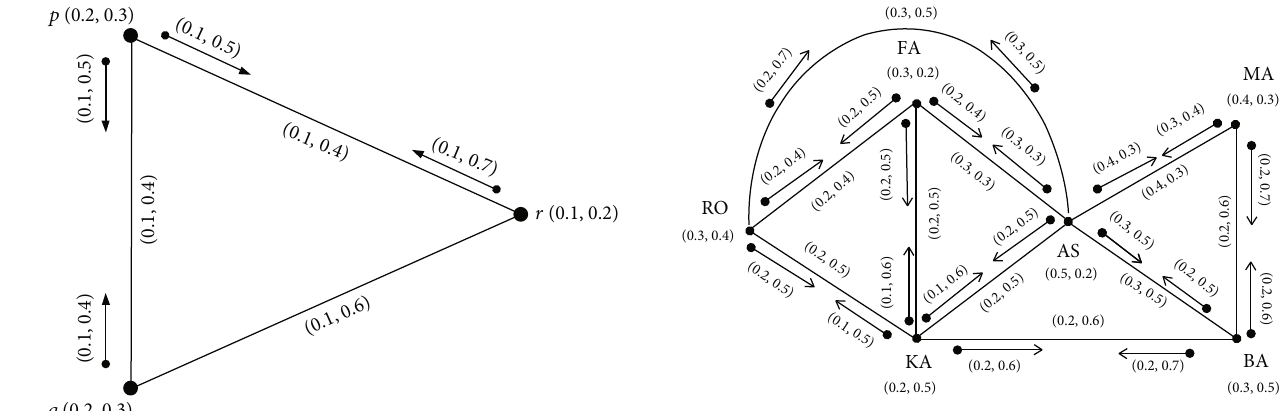
Figure 6: Vague incidence